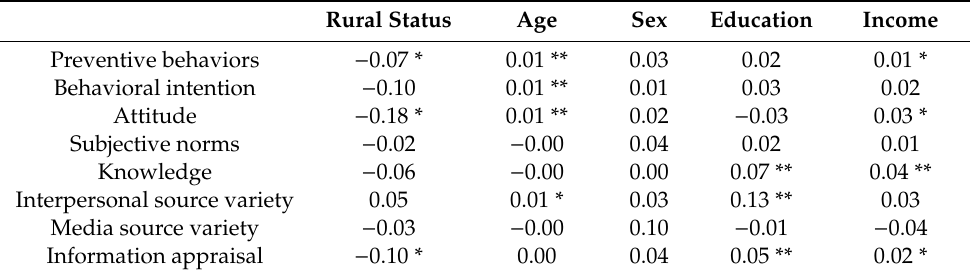
Table 1. Regression coefficients of rural/urban differences, controlling for sociodemographic.